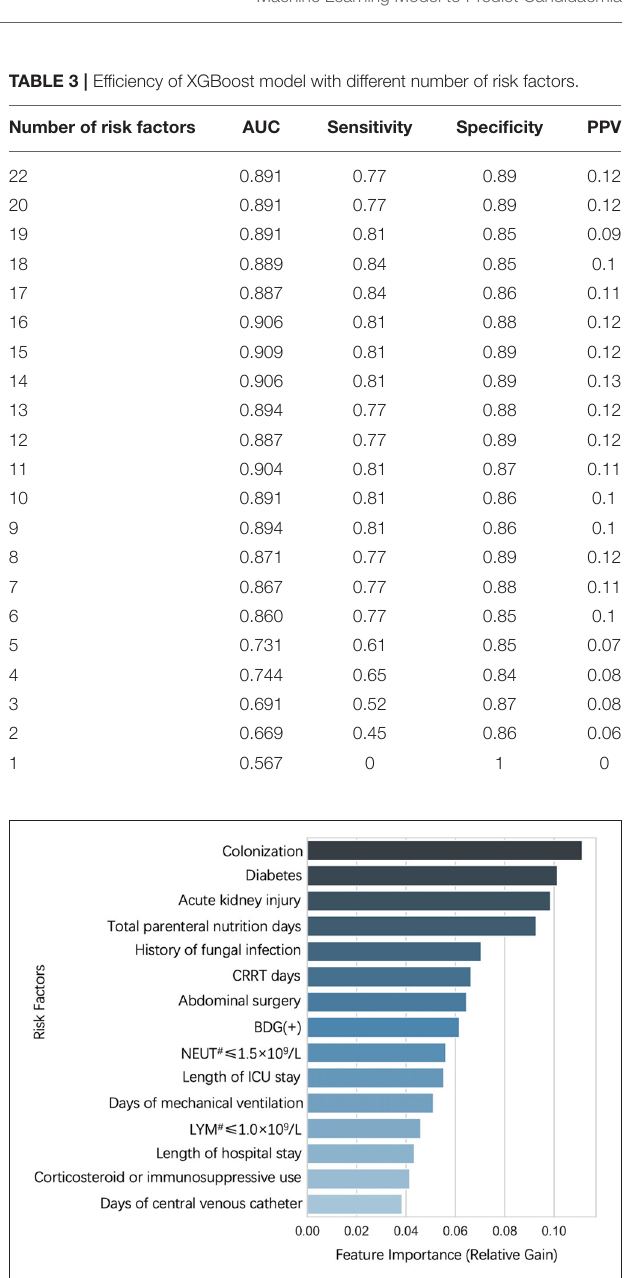
FIGURE 2 | The 15 features with the highest relative gain for model predicting candidemia.